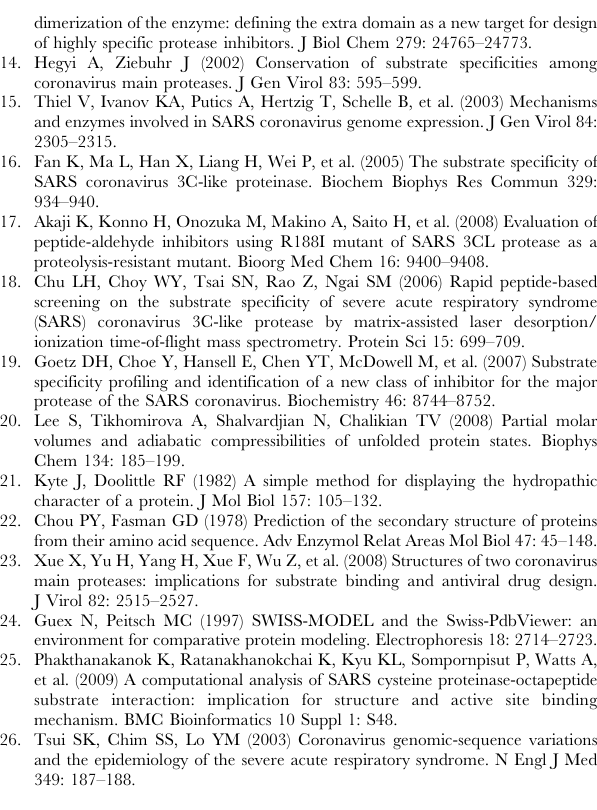
Table S2 Scales for quantification of structural properties. The side chain volume was derived from the partial molar volume of amino acids reported in Lee et al. [20]. Scales of hydrophobicity and secondary structure propensities were obtained from Kyte & Doolittle [21] and Chou & Fasman [22],